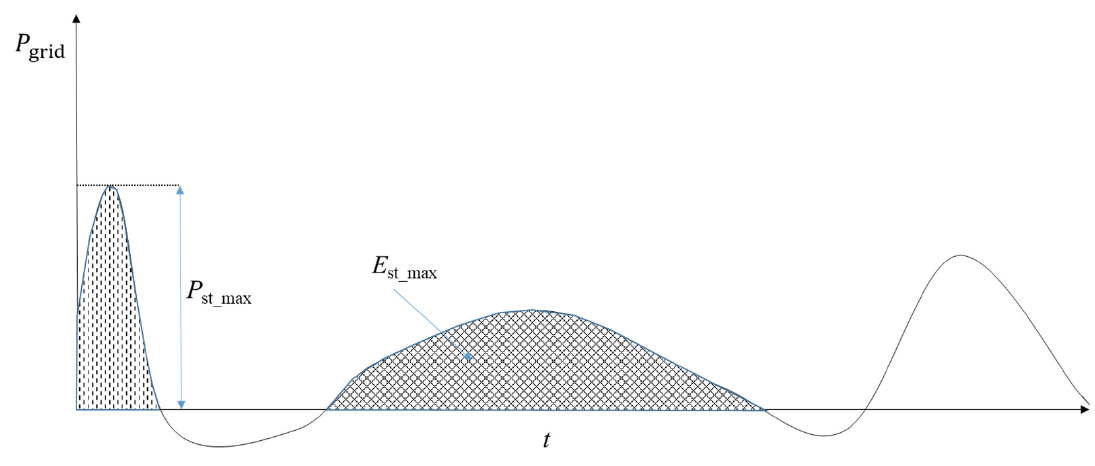
Figure 7. Qualitative visualization of energy storage systems sizing approach. Li-ion, sodium-sulfur, and flow batteries might be chosen as electric energy storage